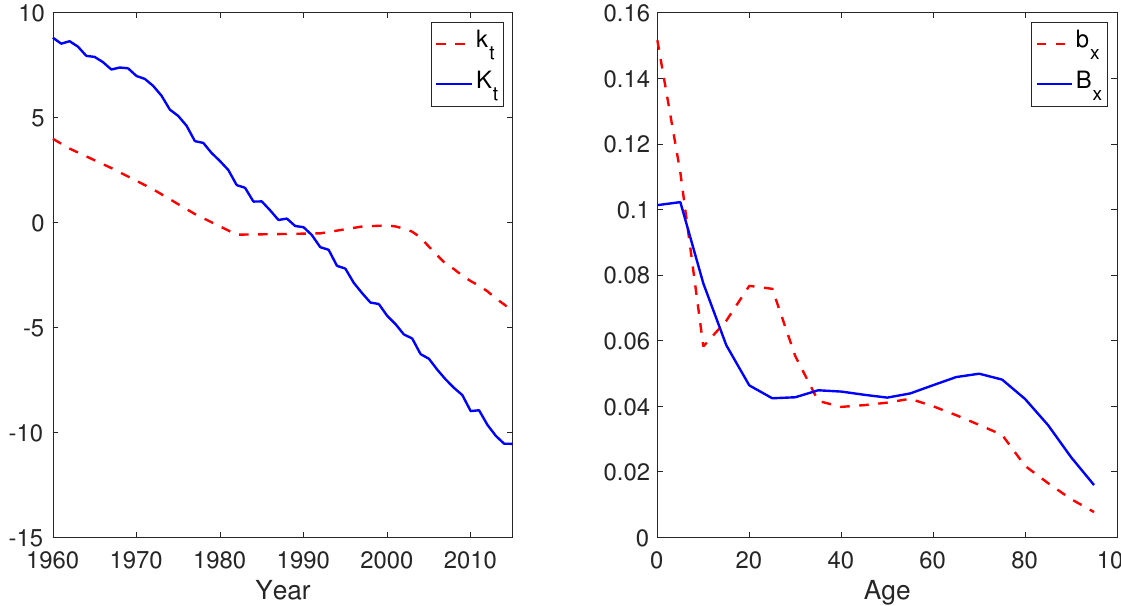
Figure 8. The historical period effects ( left panel ) and the age effects ( right panel ) of Nigeria and the benchmark